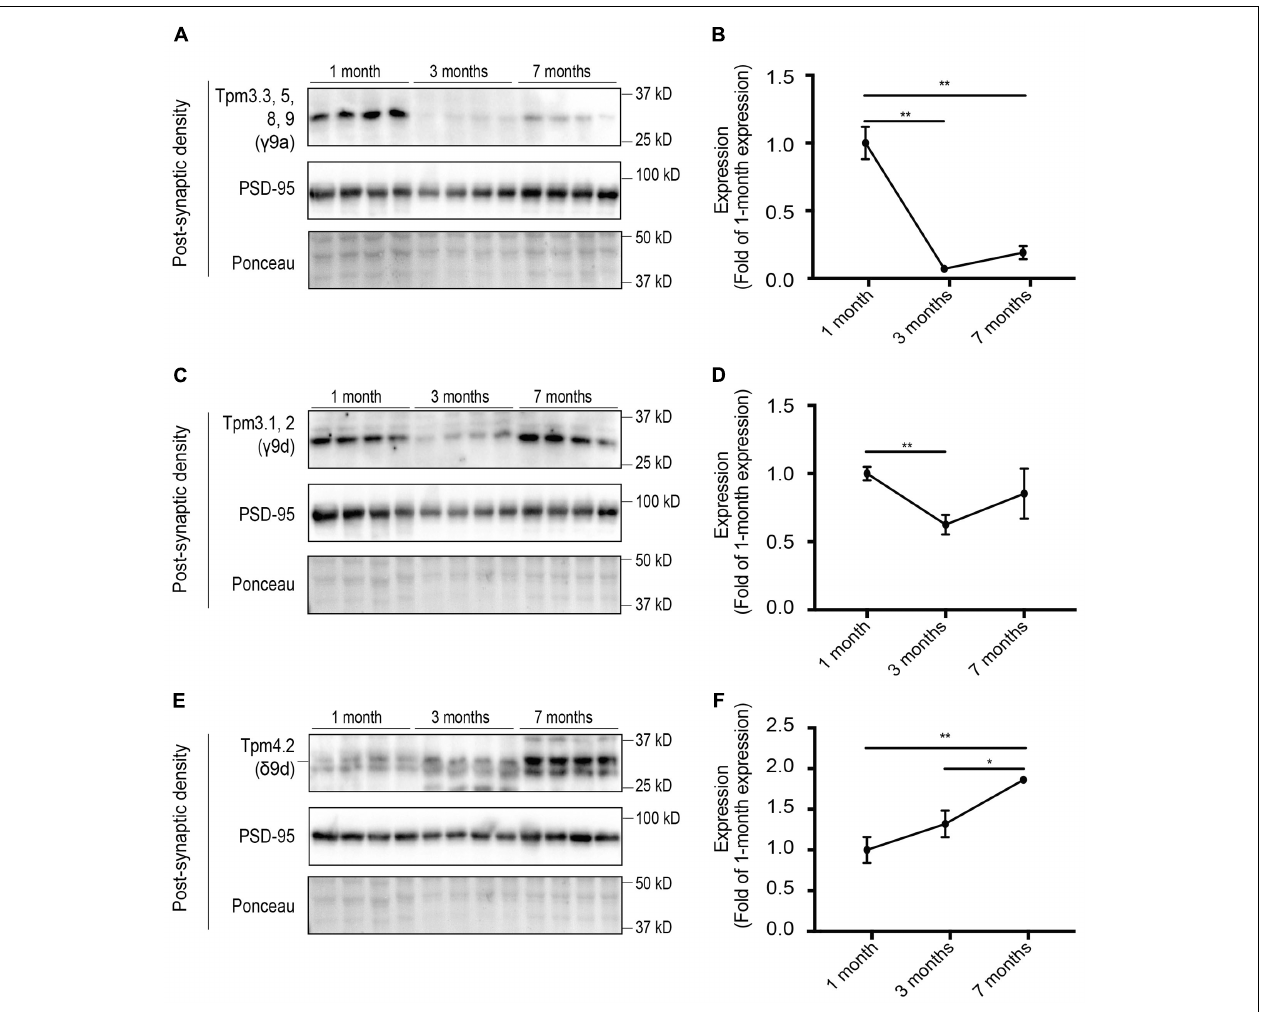
FIGURE 8 | Western blot analysis of the relative expression of tropomyosin (Tpm) isoforms at the post-synaptic density (PSD) in 1, 3, and 7-months-old mice. (A) Expression profile of Tpm3 exon 9a-containing Tpm isoforms utilizing the γ 9a mouse monoclonal antibody in the PSD of 1, 3, and 7-months-old mice. (B) Quantification of (A) normalized to expression at 1-month of age. (C) Expression profile of Tpm3.1 and Tpm3.2 utilizing the polyclonal γ /9d sheep antibody in the PSD of 1, 3, and 7-months-old mice. (D) Quantification of (C) normalized to expression at 1-month of age. (E) Expression profile of Tpm4.2, utilizing the δ 9d antibody, in the PSD of 1, 3 and 7-months-old mice. (F) Quantification of (E) normalized to expression at 1-month of age. (mean ± SEM, n = 4, ∗ P < 0.05, ∗∗ P <